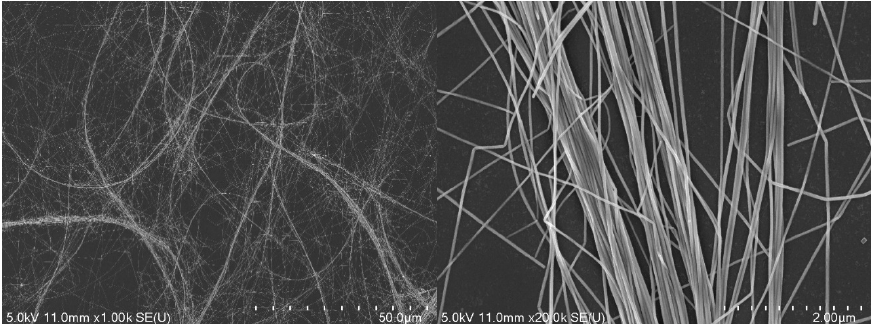
Figure 3. The Cu NWs were synthesized via a hexadecylamine (HDA)-mediated method. The NWs had a diameter of 55.3 ± 7.1 nm and a length greater than 100 μ m.